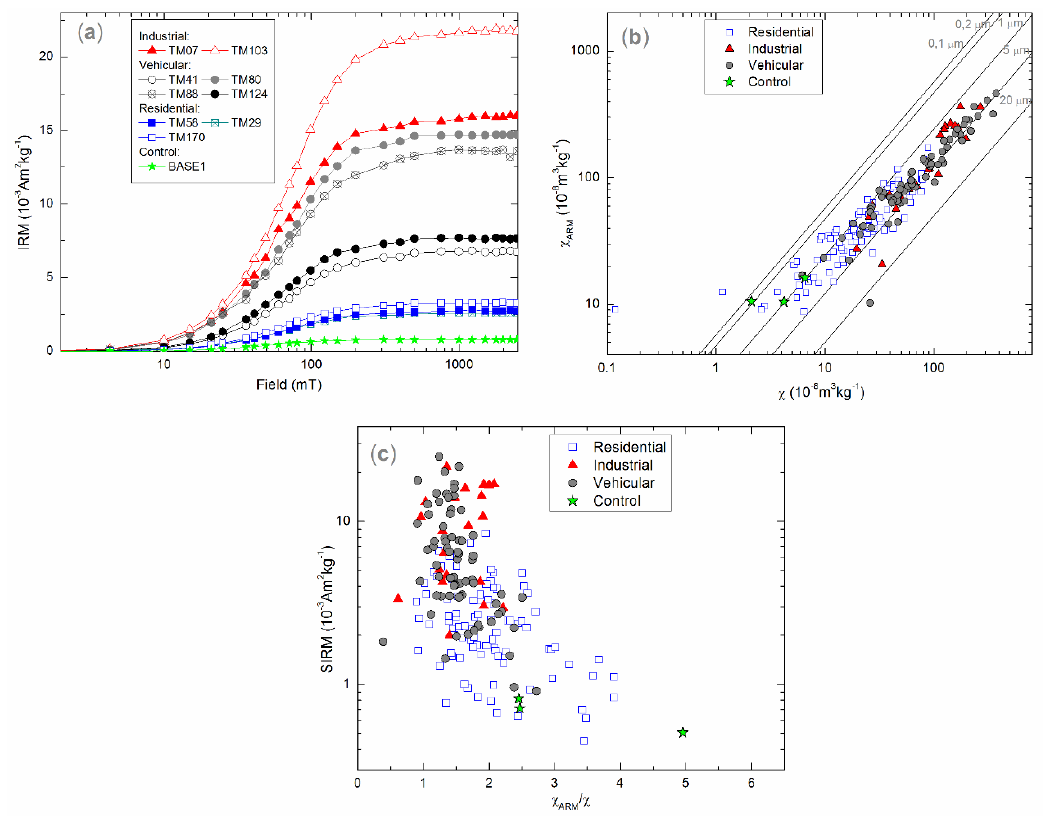
Figure 2. Magnetic parameters and biplots. ( a ) Measurements of IRM (isothermal remanent magnetization) acquisition for selected samples. ( b ) King’s Plot (χ ARM versus χ) for all samples. The magnetic grain size of most of the samples is between 1 and 5 μm. ( c ) Biplot of concentration parameter SIRM (IRM saturation) versus grain size dependent parameter χ ARM /χ for all samples.